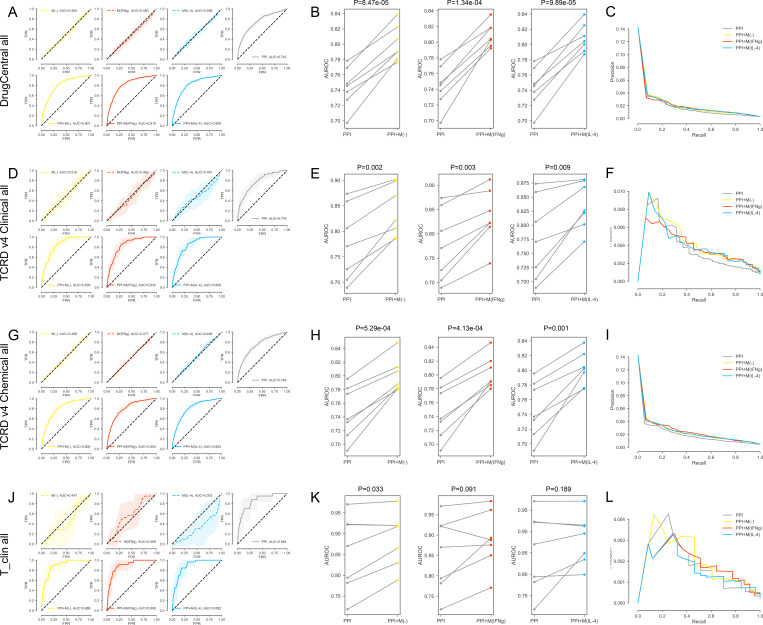
(A-C) For the DrugCentral all drug targets. (A) The k-fold cross-validated (k = 7) ROC curves for M(-), M(IFNγ), M(IL-4), PPI, PPI + M(-), PPI + M(IFNγ) and PPI + M(IL-4), respectively.Shaded regions represent the standard deviation of the AUROC values from all folds.(B) The AUROC values of each individual fold from the cross-validation for PPI and PPI + M(-), PPI and PPI + M(IFNγ), PPI and PPI + M(IL-4), respectively. Paired t-test was performed to obtain two-sided p-values. (C) Precision-recall curves for PPI, PPI + M(-), PPI + M(IFNγ) and PPI + M(IL-4). (D–F) For the TCRDv4 Clinical all drug targets: (D) The k-fold cross-validated (k = 7) ROC curves for M(-), M(IFNγ), M(IL-4), PPI, PPI + M(-), PPI + M(IFNγ) and PPI + M(IL-4), respectively. Shaded regions represent the standard deviation of the AUROC values from all folds. (E) The AUROC values of each individual fold from the cross-validation for PPI and PPI + M(-), PPI and PPI + M(IFNγ), PPI and PPI + M(IL-4), respectively. Paired t-test was performed to obtain two-sided p-values. (F) Precision-recall curves for PPI, PPI + M(-), PPI + M(IFNγ) and PPI + M(IL-4). (G–I) For the TCRDv4 Chemical all drug targets: (G) The k-fold cross-validated (k = 7 for M(-) and M(IFNγ), k = 3 for M(IL-4)) ROC curves for M(-), M(IFNγ), M(IL-4), PPI, PPI + M(-), PPI + M(IFNγ) and PPI + M(IL-4), respectively. Shaded regions represent the standard deviation of the AUROC values from all folds. (H) The AUROC values of each individual fold from the cross-validation for PPI and PPI + M(-), PPI and PPI + M(IFNγ), PPI and PPI + M(IL-4), respectively. Paired t-test was performed to obtain two-sided p-values. (I) Precision-recall curves for PPI, PPI + M(-), PPI + M(IFNγ) and PPI + M(IL-4). (J–L) For the T_clin all drug targets: (J) The k-fold cross-validated (k = 7 for M(-) and M(IFNγ), k = 3 for M(IL-4)) ROC curves for M(-), M(IFNγ), M(IL-4), PPI, PPI + M(-), PPI + M(IFNγ) and PPI + M(IL-4), respectively. Shaded regions represent the standard deviation of the AUROC values from all folds. (K) The AUROC values of each individual fold from the cross-validation for PPI and PPI + M(-), PPI and PPI + M(IFNγ), PPI and PPI + M(IL-4), respectively. Paired t-test was performed to obtain two-sided p-values. (L) Precision-recall curves for PPI, PPI + M(-), PPI + M(IFNγ) and PPI + M(IL-4).